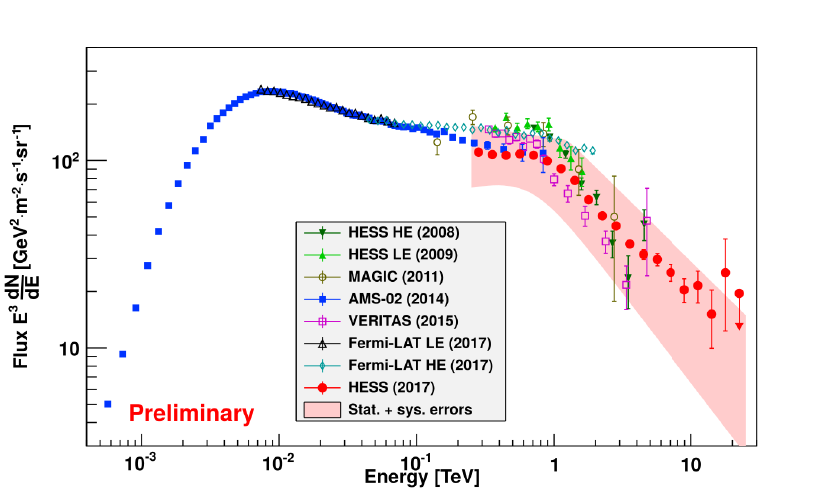
Figure 3. Cosmic-ray electrons energy spectrum measured with H.E.S.S. in 2017 (red dots) compared to previous measurements from various